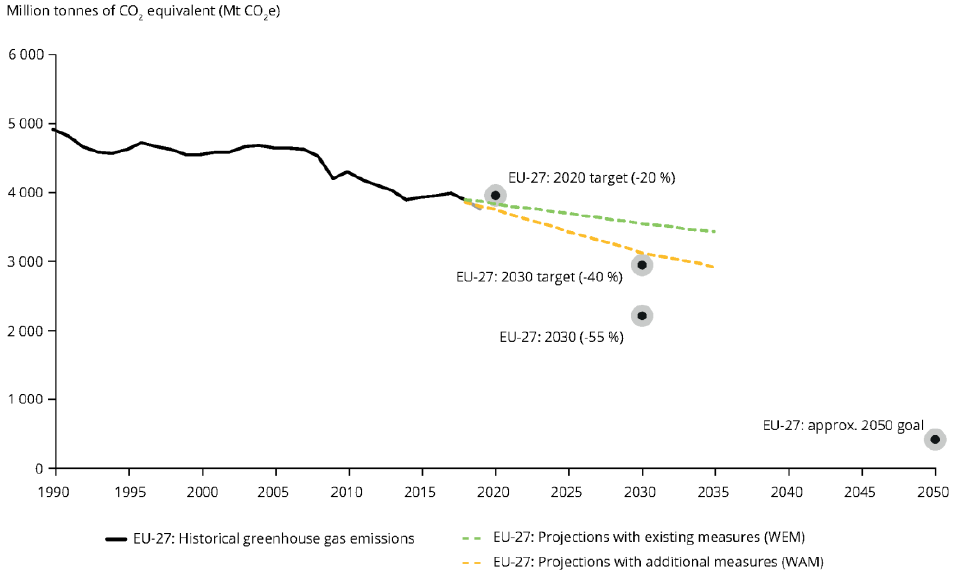
Figure 1. Greenhouse gas emission targets, trends, and Member States’ MMR projections in the EU, 1990–2050. Source: https://www.eea.europa.eu/data-and-maps/indicators/greenhouse-gas- emission-trends-7/assessment (accessed on 5 August